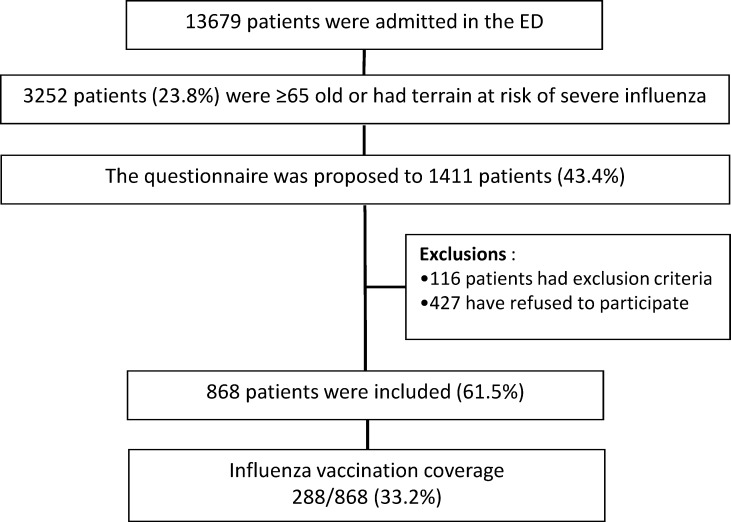
Study flowchart.